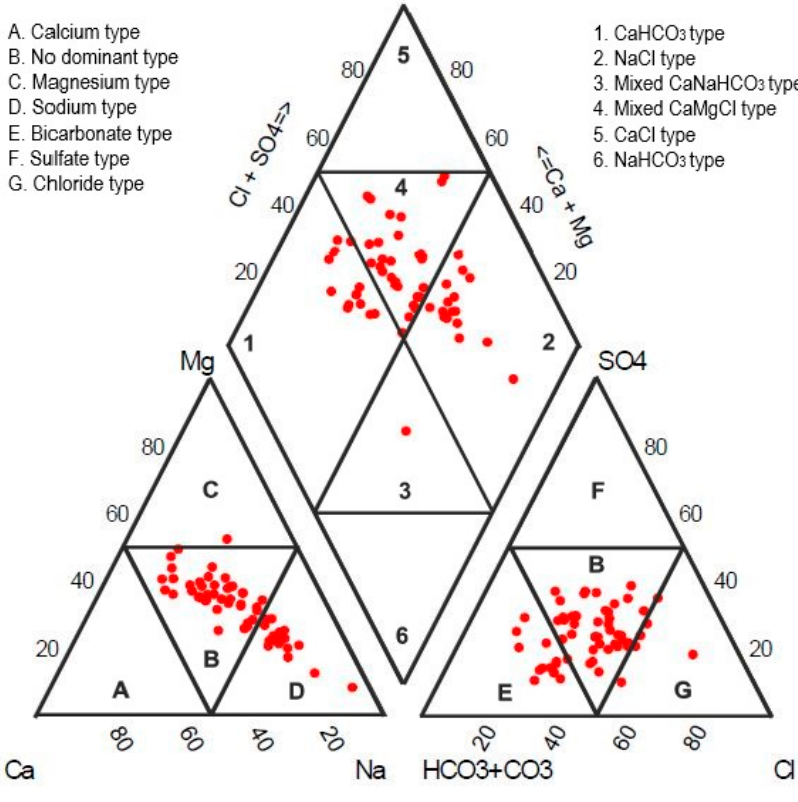
Figure 2. Piper plot for groundwater facies classification.